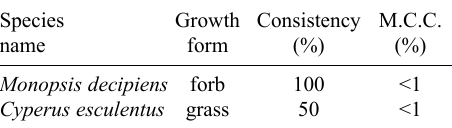
Diagnostic species of the Eragrostis plana-Monopsis decipiens - grassland (M.C.C. - mean canopy cover) Species Growth Consistency M.C.C.